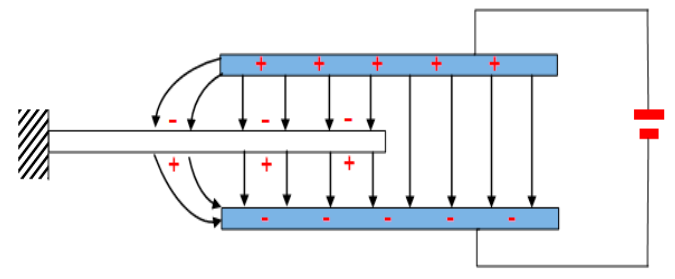
Figure 3. The electrostatic field.